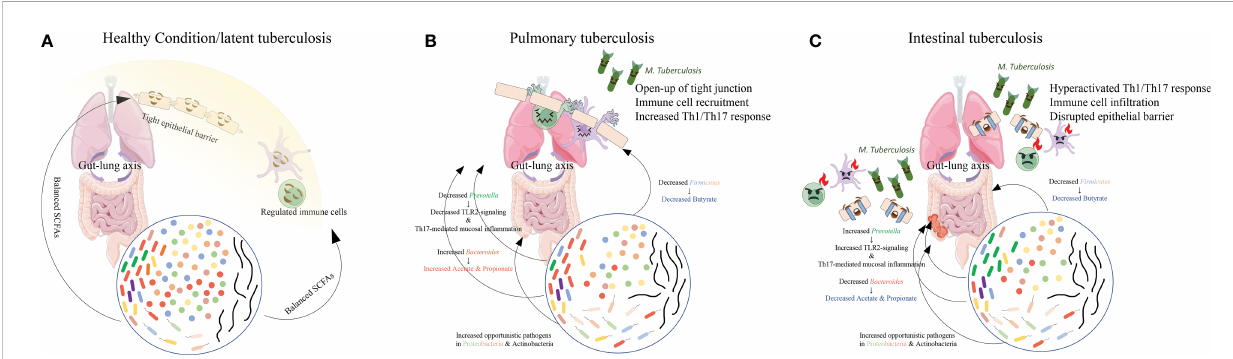
FIGURE 2 The main fi ndings in gut microbiome composition in PTB and ITB patients. Compared with the healthy conditions (A) , in PTB patients (B) , reduced Firmicutes and Prevotella and increased Bacteroides altered the proportion of each SCFA, causing immune cell recruitment and mildly increased immune response. However, when Bacteroides decreased and Prevotella increased (C) , decreased SCFAs production resulted in drastic activation of immune response and disruption of epithelial barrier, facilitating the colonization of M. tuberculosis in the intestine and the development of